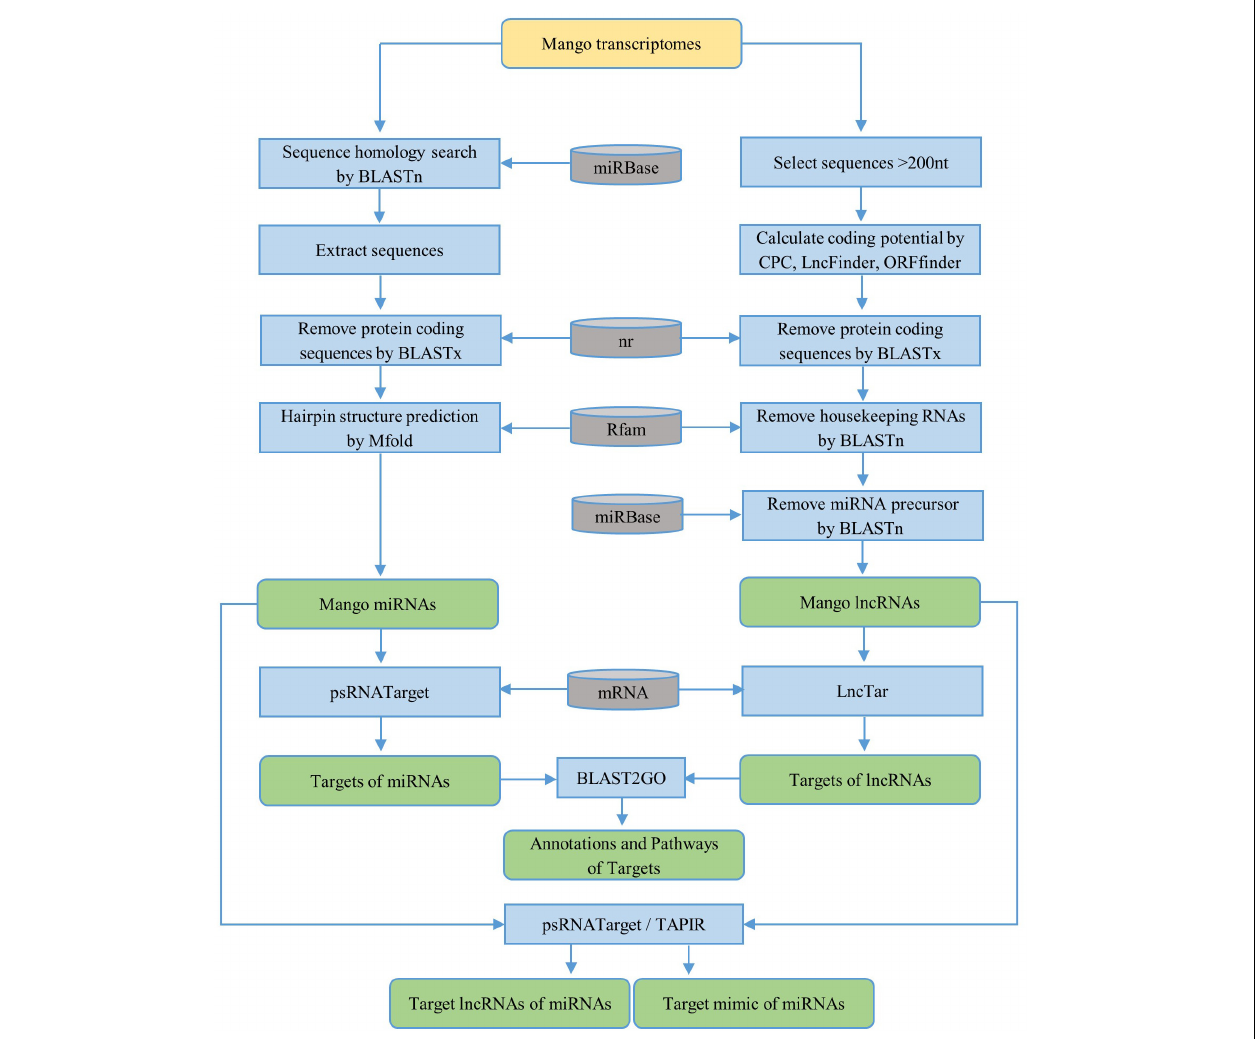
FIGURE 1 | Workflow for the identification of ncRNAs [microRNAs (miRNAs) and long non-coding RNAs (lncRNAs)] and their targets. The yellow rounded rectangle represents the data input and the green rounded rectangles represent the data output. The blue rectangles are the processing steps and the gray cans represent